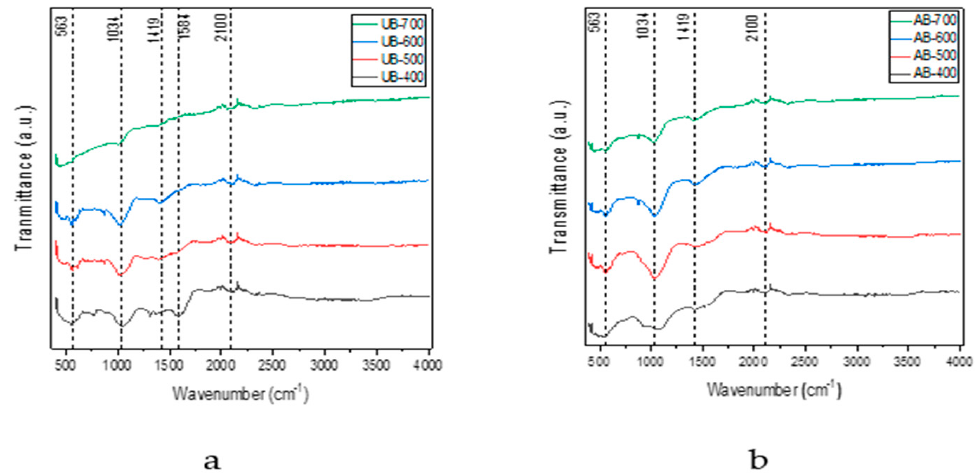
Figure 4. Infrared spectra of ( a ) unactivated biochar (UB) and ( b ) activated biochar (AB) synthesized at various pyrolysis temperatures of 400–700 °C.